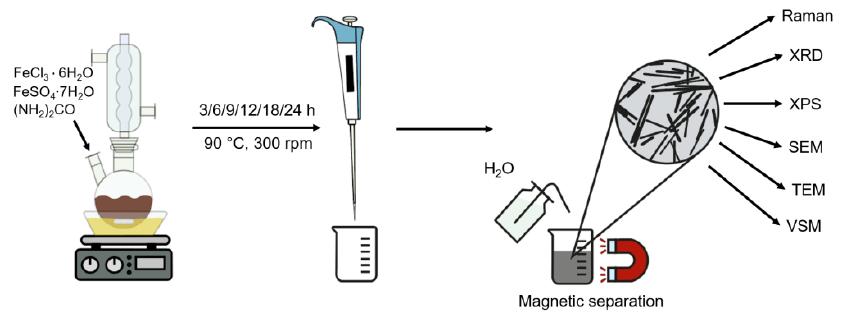
Figure 1. Methodology of the synthesis and investigation of iron oxide ANPs.